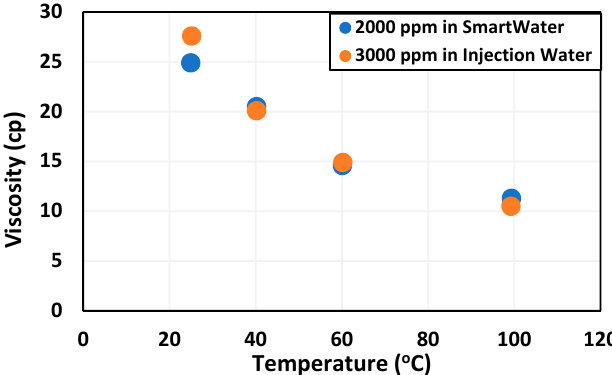
Figure 11. The effect of smart water on the polymer concentration required to achieve the target viscosity [180].